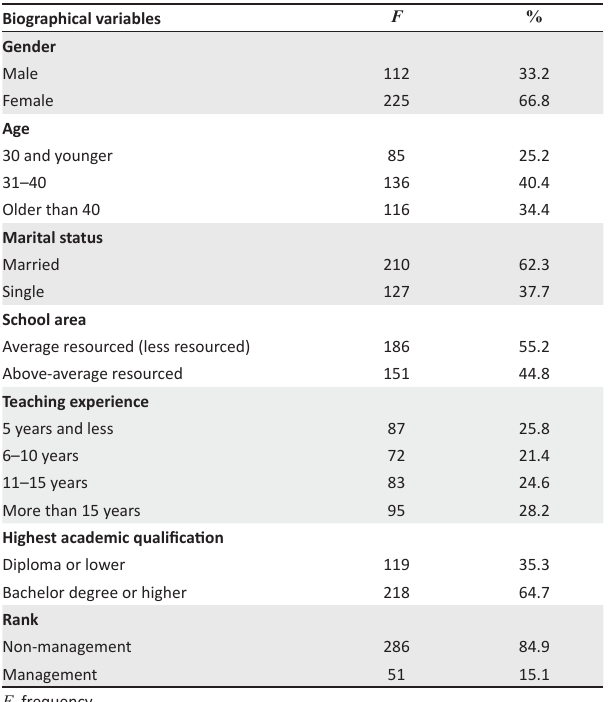
TABLE 1: Frequency distribution of biographical variables.